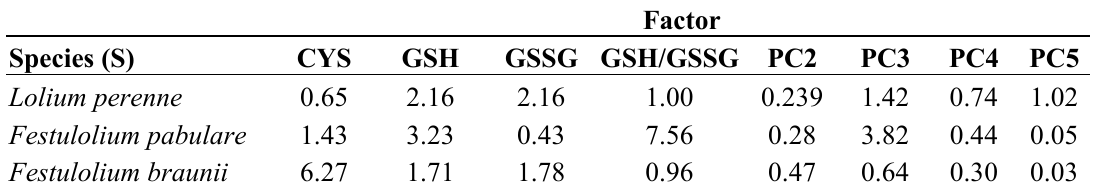
Table 2. Effect of Species (S) on contents of CYS, GSH, GSSG, PC2, PC3, PC4, PC5, and GSH/GSSG ratio in pots experiment. Content of CYS, GSH and GSSG is expressed as µg/g of fresh weight. PC2, PC3, PC4, and PC5 are expressed as ng/g of fresh weight.